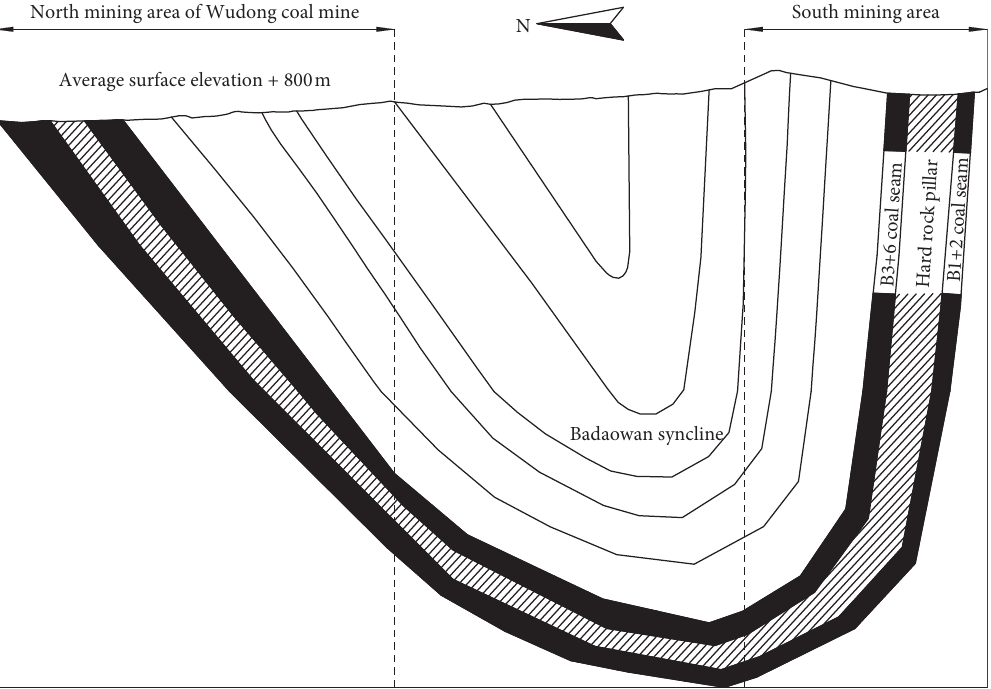
Figure 1: Geological profile of the Wudong coal mine.